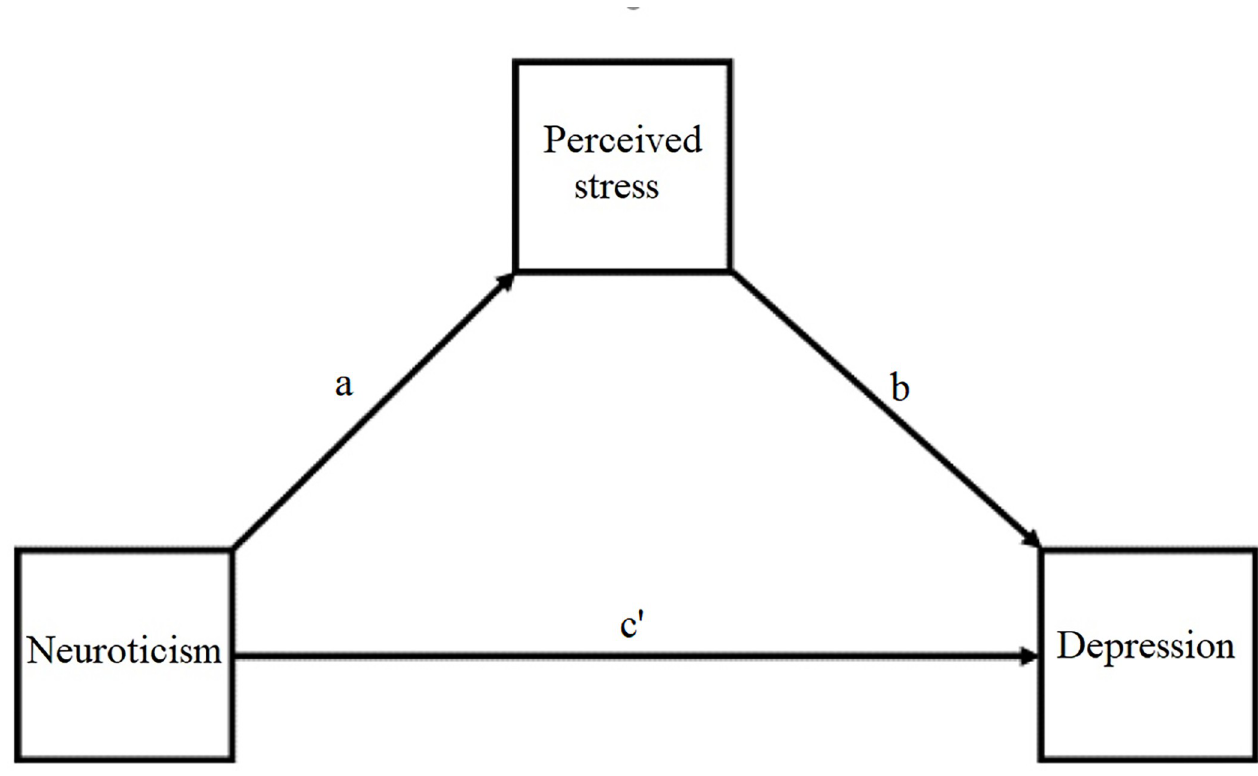
Fig 1. The hypothesized mediation